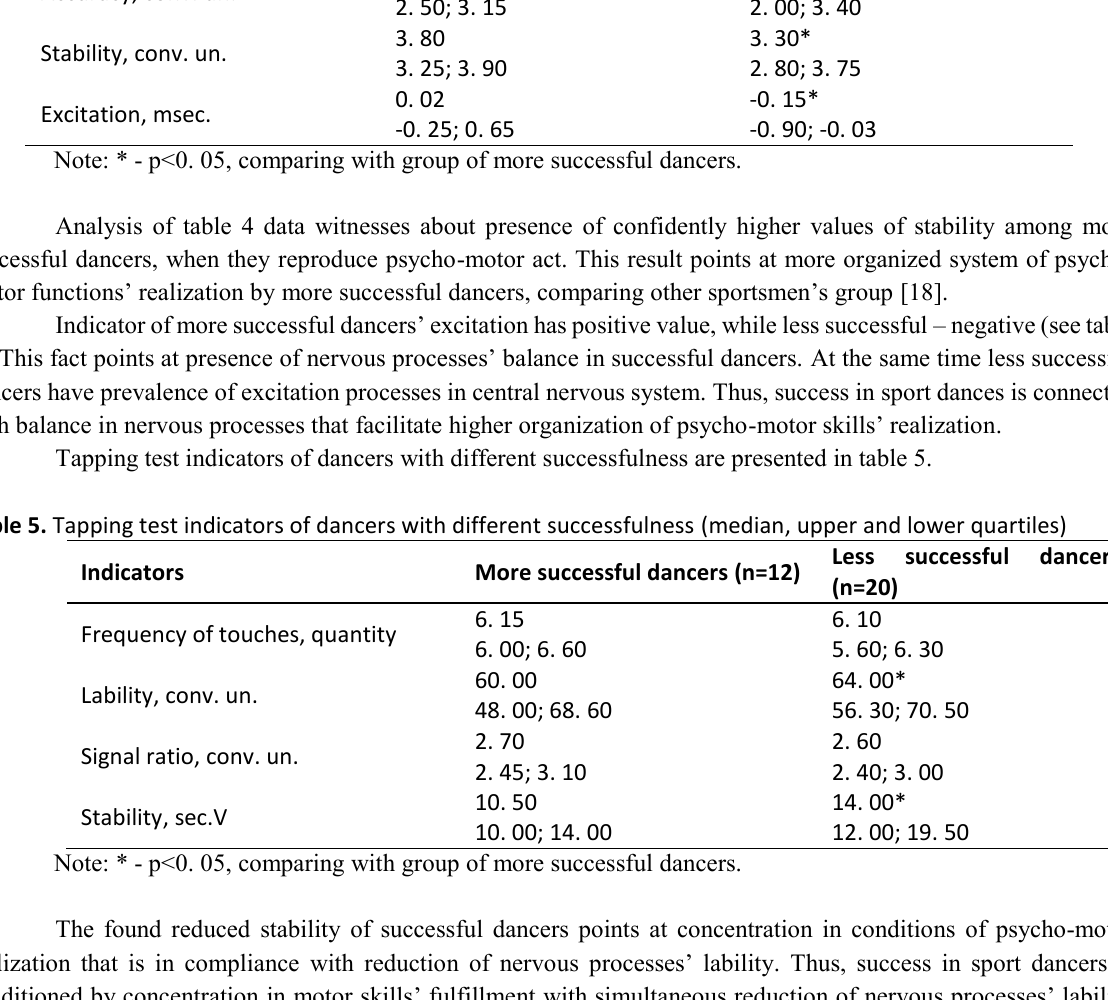
Table 4. Indicators of nervous processes balance of dancers with different successfulness (median, upper and lower quartiles) Indicators More successful dancers (n=12) Accuracy, conv. un. Stability, conv. un. Excitation, msec.